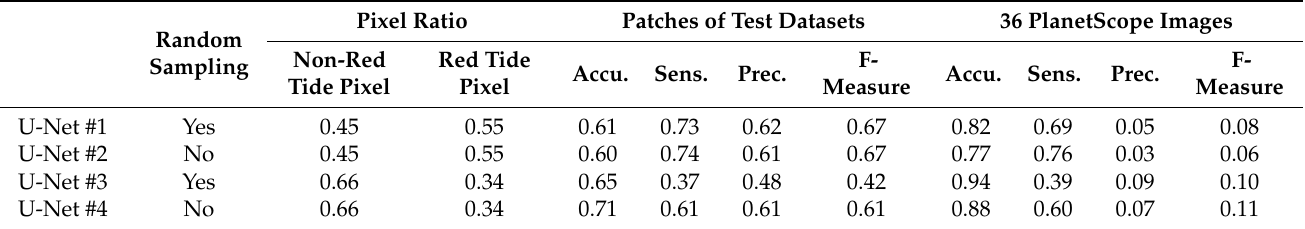
Table 5. Quantitative performance of U-Net models trained (50 mini-batches, 50 epochs) with four different training and test datasets. Four datasets were chosen randomly or non-randomly with different ratios of non-red tide and red tide pixels. Four FOMs of the models were evaluated using patches of test datasets and 36 PlanetScope